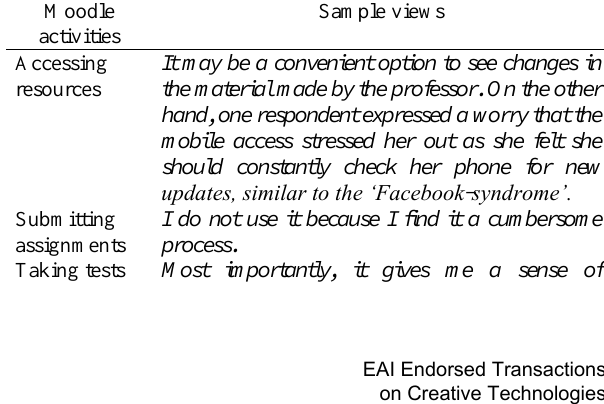
Table 2. Students representative